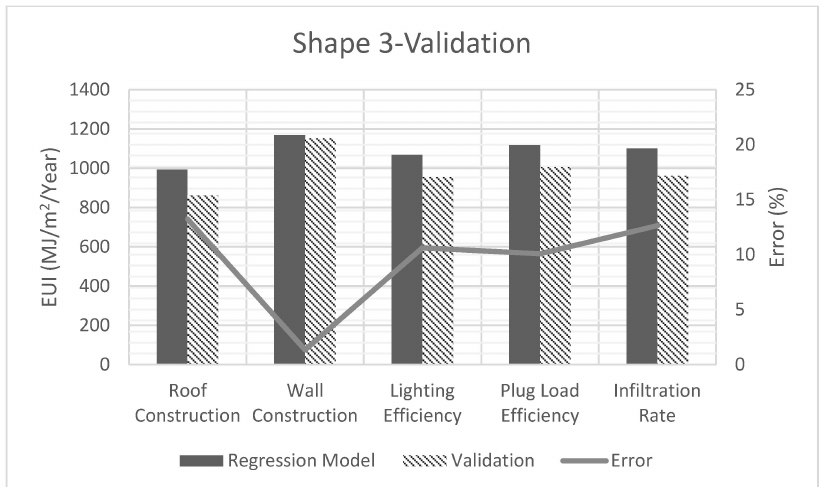
Figure 22. TETB Shape 3